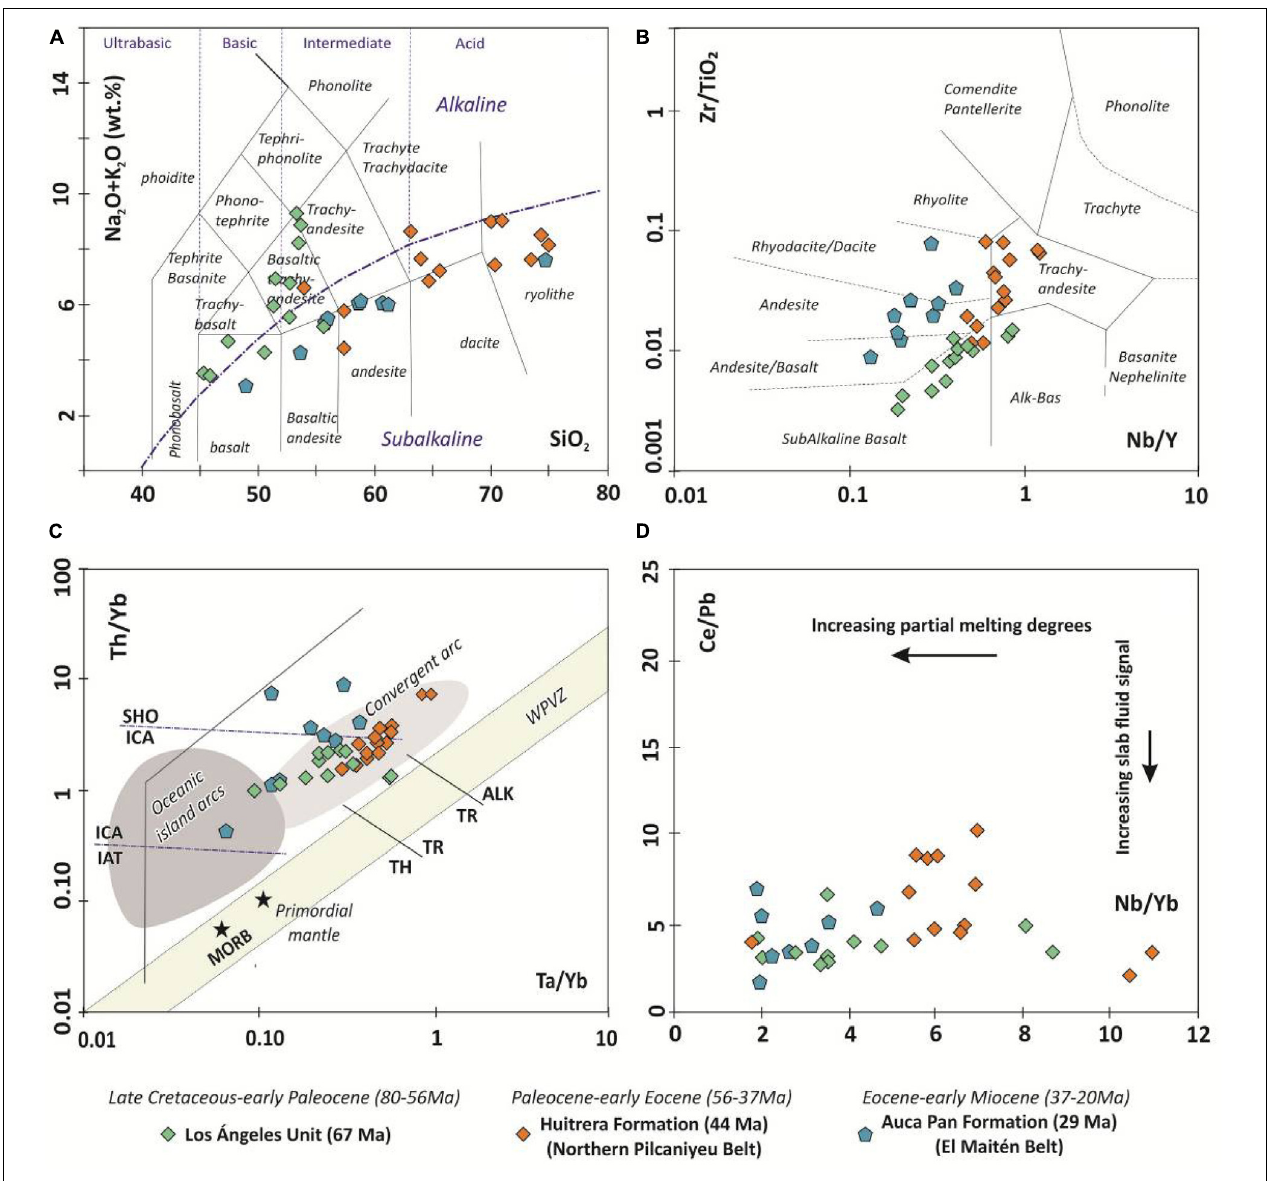
FIGURE 4 | (A) TAS classification diagram for studied Late Cretaceous, Eocene, and Oligocene sequences (Irvine and Baragar, 1971; Le Maitre et al., 1989). (B) Trace elements classification plot showing important differences between the three studied sequences. (C) Th/Yb vs. Ta/Yb diagram proposed by Pearce (1983) and modified from Xia and Li (2019), which allows constraining a tectonic setting for each studied sequence (SHO, Island arc Shoshonites; ICA, Island arcs Calc-alkaline basalts; IAT, Island arc Tholeiites; TH, Tholeiitic series; TR, Transitional series; ALK, Alkaline series; MORB, Mid-ocean ridge basalts; WPB, Within-plate basalts). (D) Ce/Pb vs. Nb/Yb as indicators of partial melting degrees and slab-fluid influence. Geochemical data are from Iannelli et al. (2017,